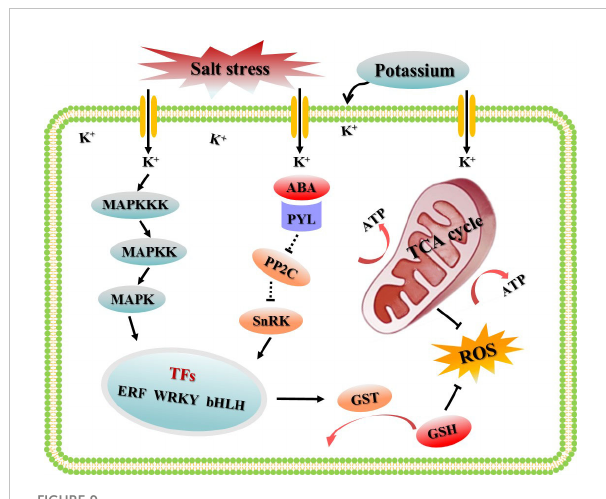
FIGURE 9 Schematic diagram of the regulatory mechanism by which potassium improves the salt adaptability of cotton roots based on